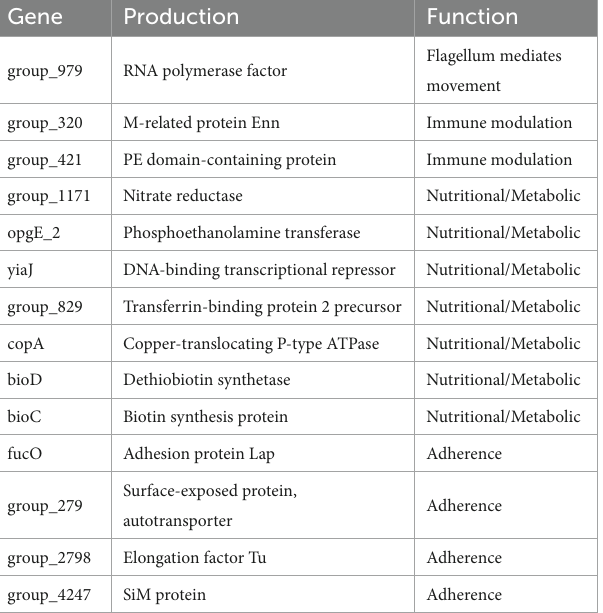
TABLE 11 VFDB annotation of strong biofilm formation-associated